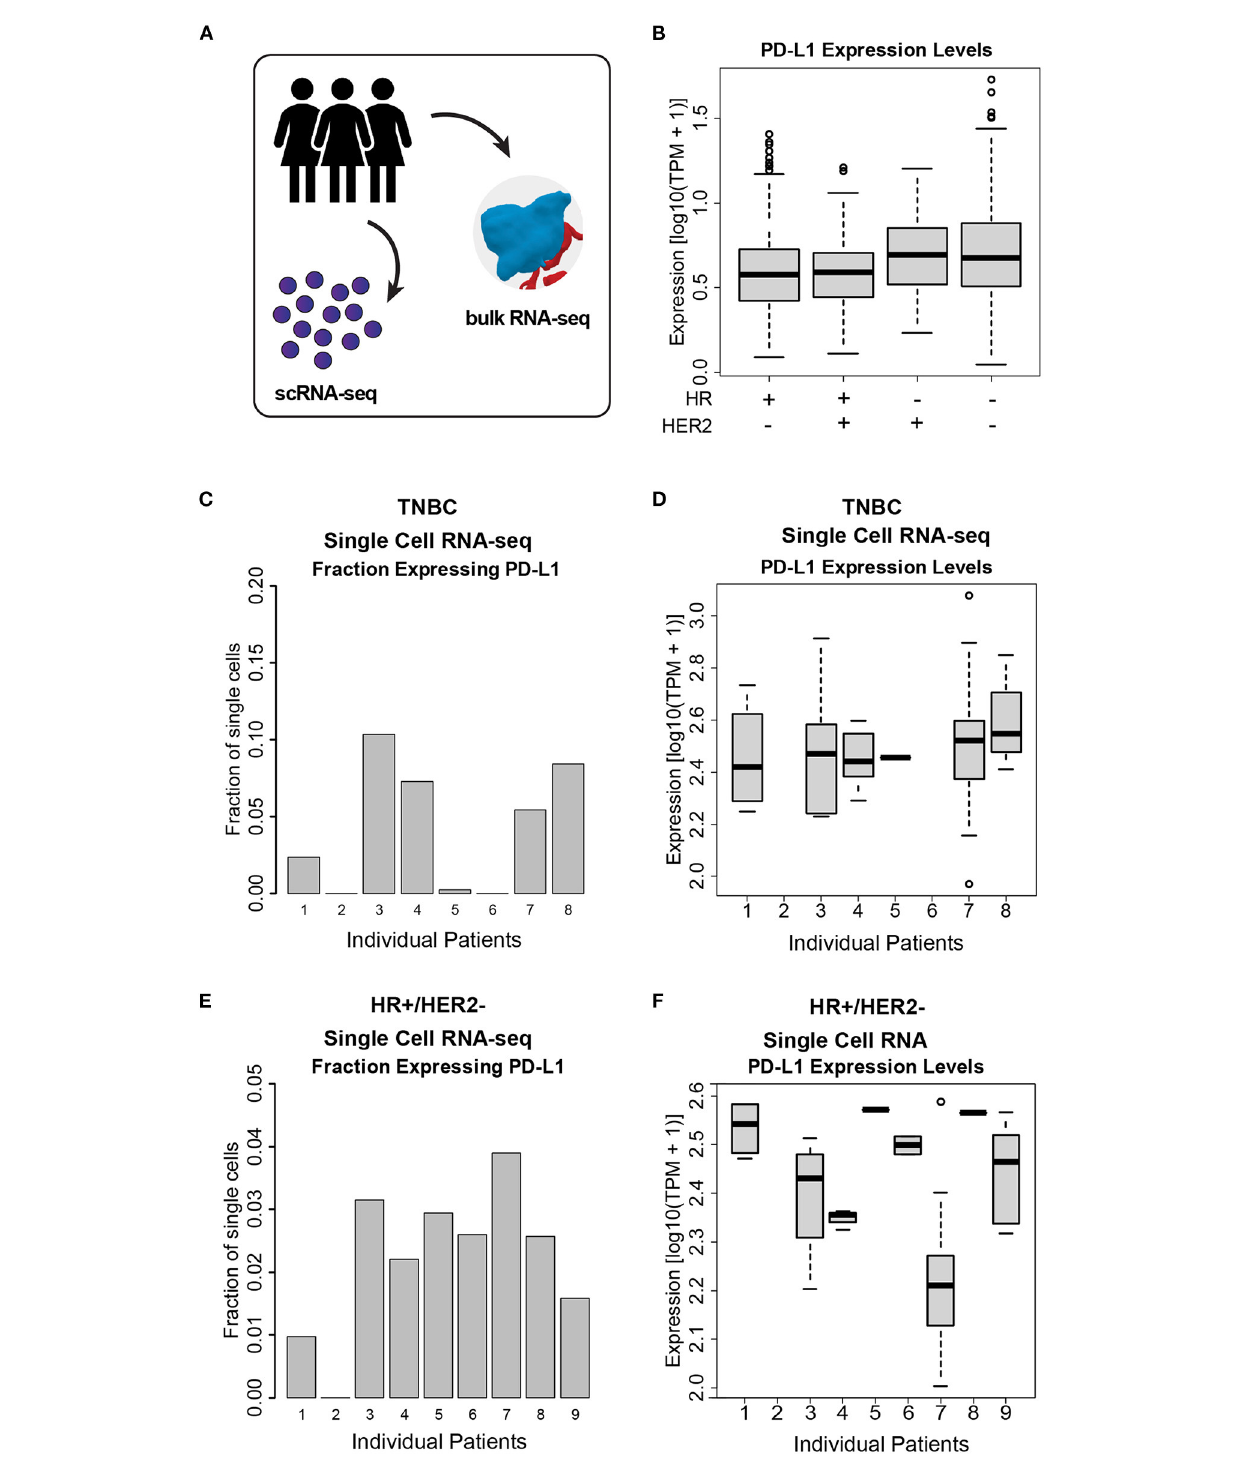
FIGURE3 PD-L1 heterogeneity across and within ESBC tumors. (A) Schematic of experimental approach depicting use of both scRNA-seq and whole-tumor bulk RNA-seq. (B) PD-L1 expression levels in bulk RNA-seq from 972 ESBC patients from the I-SPY2 trial. (C) Fraction of cells expressing PD-L1 in TNBC tumor cells, as judged by scRNA-seq from eight patients. (D) PD-L1 expression levels within single cells across TNBC tumors. (E) Fraction of cells expressing PD-L1 in HR /HER2- tumors, as judged by scRNA-seq from nine patients. (F) PD-L1 expression levels across HR /HER2- tumors. In + + (C–F) , individual patients with no representative data indicate that no PD-L1 cells were detected in these samples (i.e., HR /HER2- patient 2, TNBC + + patient 2, and TNBC patient